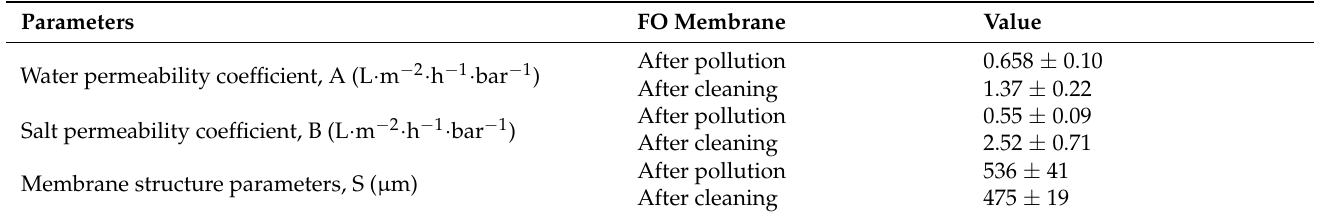
Table 4. Changes in basic properties of FO membranes before and after cleaning.